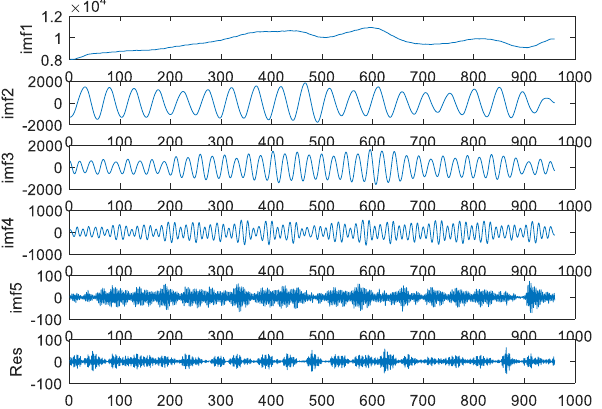
Figure 9. The VMD decomposition provided the IMF component and the Res component.